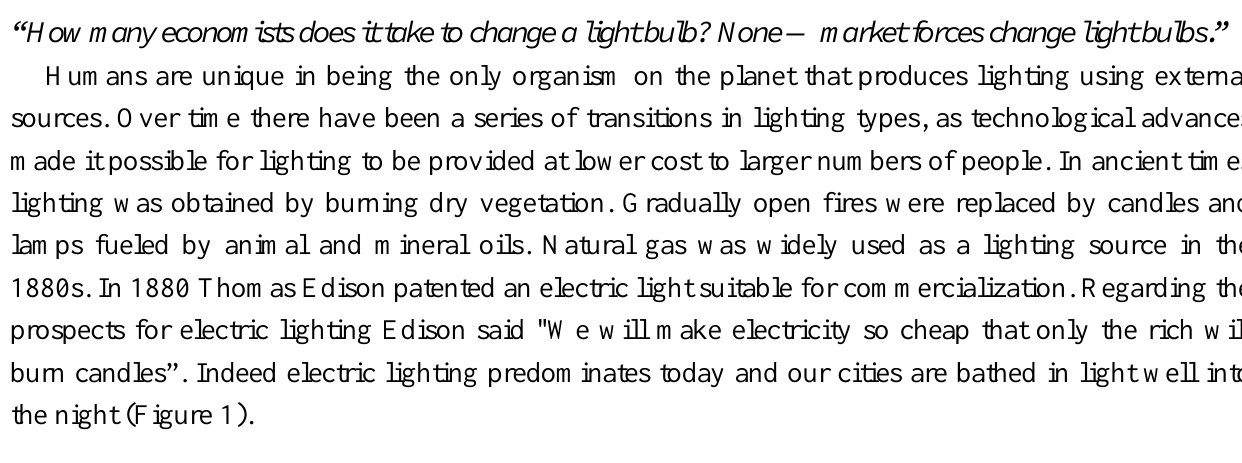
Figure 1. Shanghai, China at